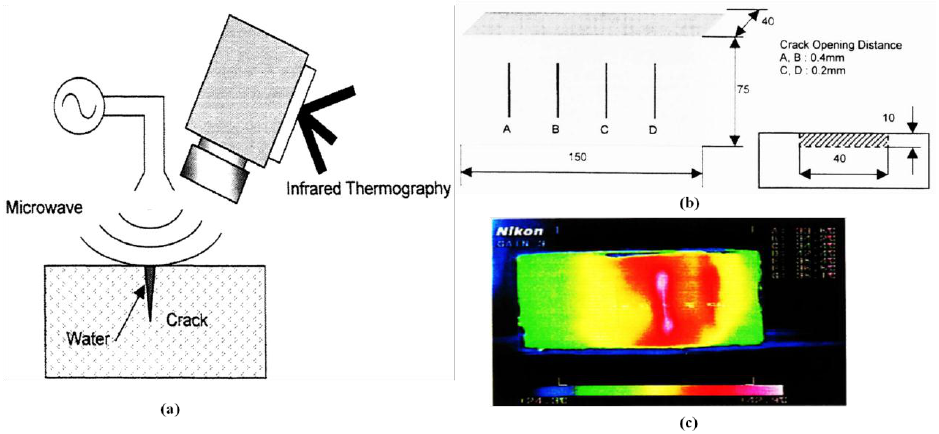
Figure 9. Schematic diagram of MWT ( a ), mortar block specimen with artificial cracks ( b ) and thermal images taken after microwave heating ( c ) [61]. Reprinted/reproduced with permission from SPIE.